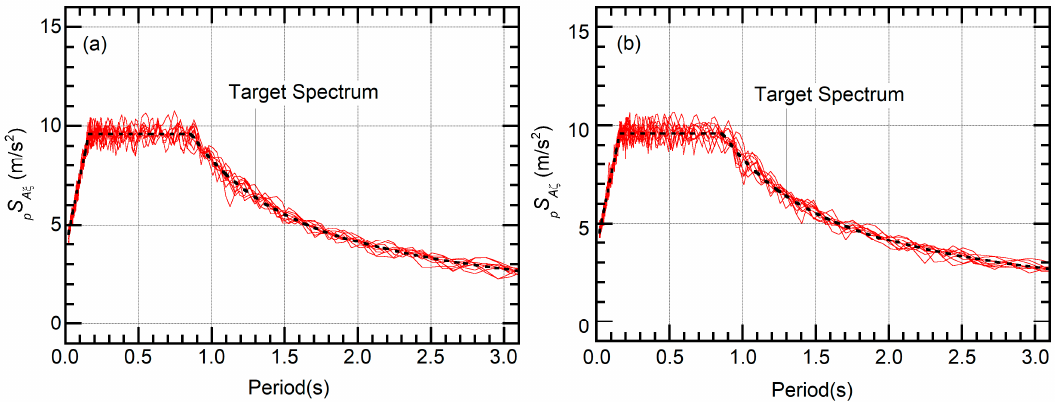
Figure 13. Response spectra of the elastic acceleration.